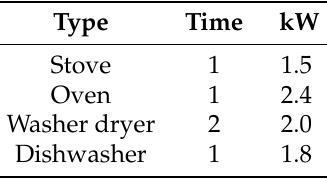
Table 1. Energy use and operating time for different